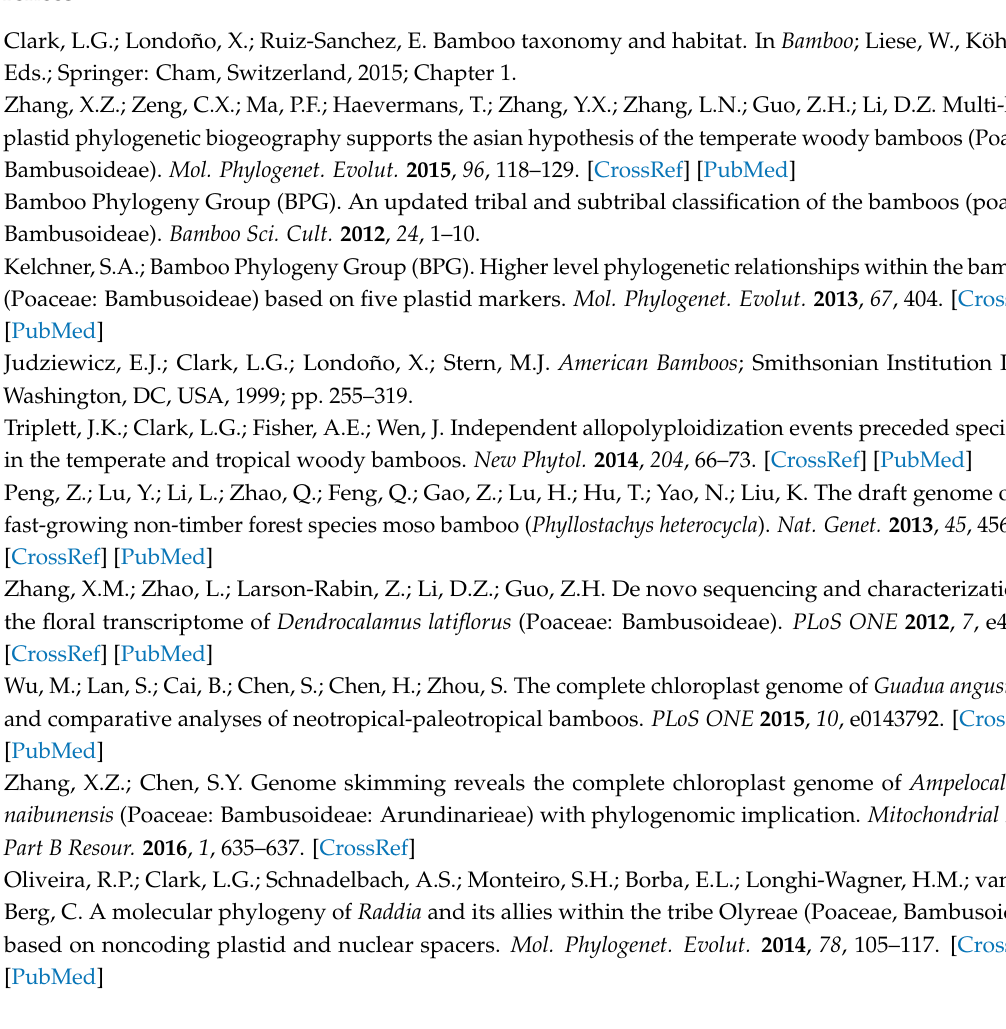
Table S1: Plastomes of Bambusoideae and allied grasses analyzed in this